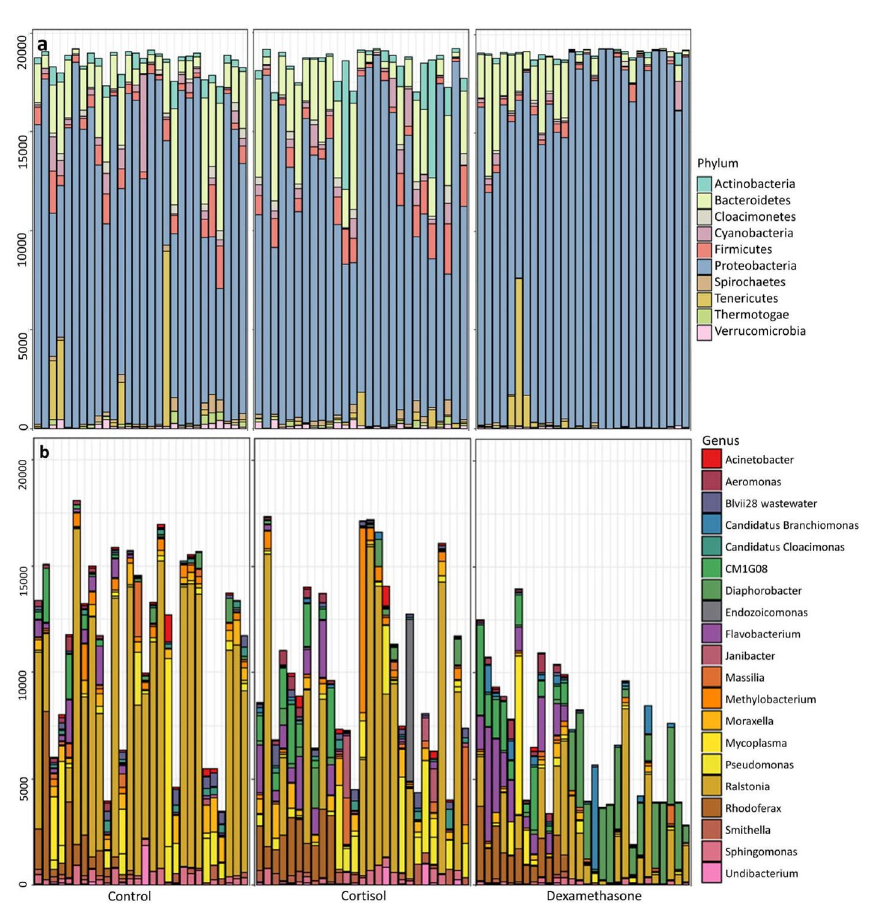
Figure 3. Rarefied abundances of ( a ) the top ten most abundant phyla and ( b ) the top 20 most abundant genera present juvenile Chinook salmon treated with vehicle-only control, cortisol, or dexamethasone